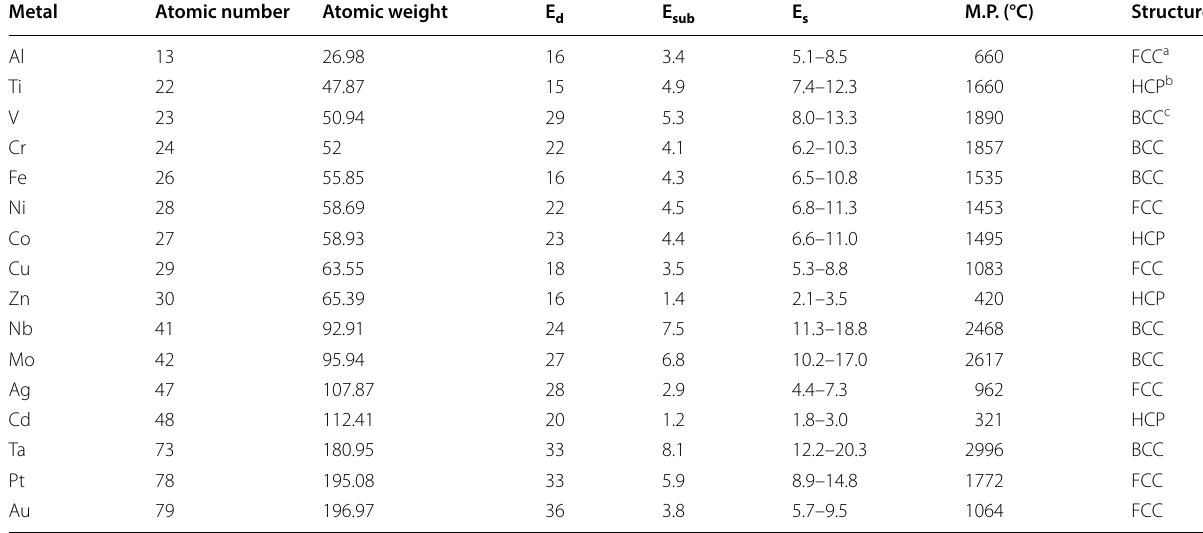
Table 1 Calculations and literature survey of E d , E sub , and E s for various metals